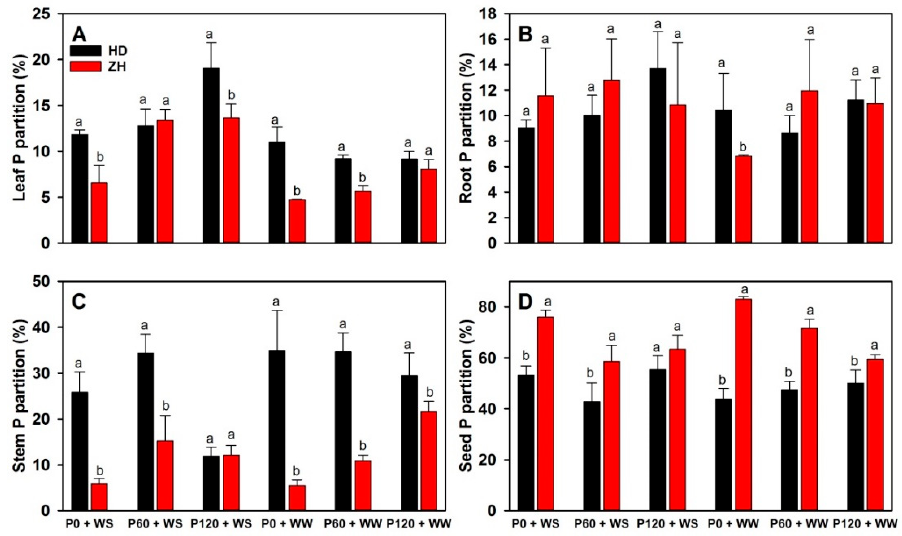
Figure 4. The P partitioning to ( A ) leaf, ( B ) stem, ( C ) root, and ( D ) seed in two cultivars (Huangsedadou (HD) and Zhonghuang 30 (ZH)) under two water regimes (well-watered (WW) and cyclic water stress (WS)) and three P rates (0 (P0), 60 (P60), and 120 (P120) mg P kg –1 dry soil) at maturity. Means ( ± SE) with different letters in the same panel are significantly different at p =